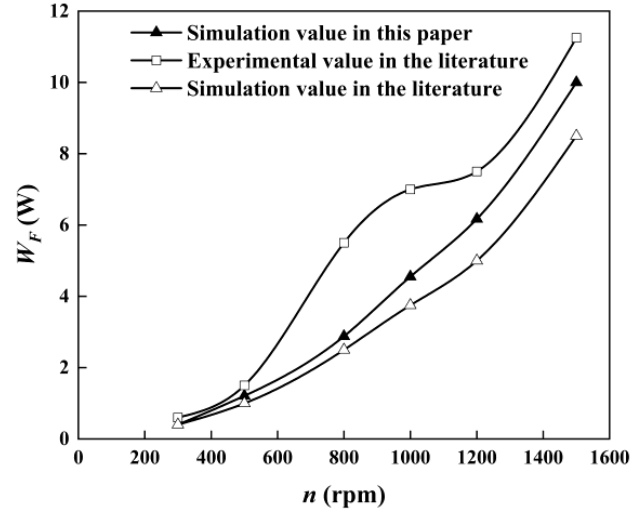
Processes 2022 , 10 , x FOR PEER REVIEW Figure 8. Comparison of the simulation results determining friction power dissipation.